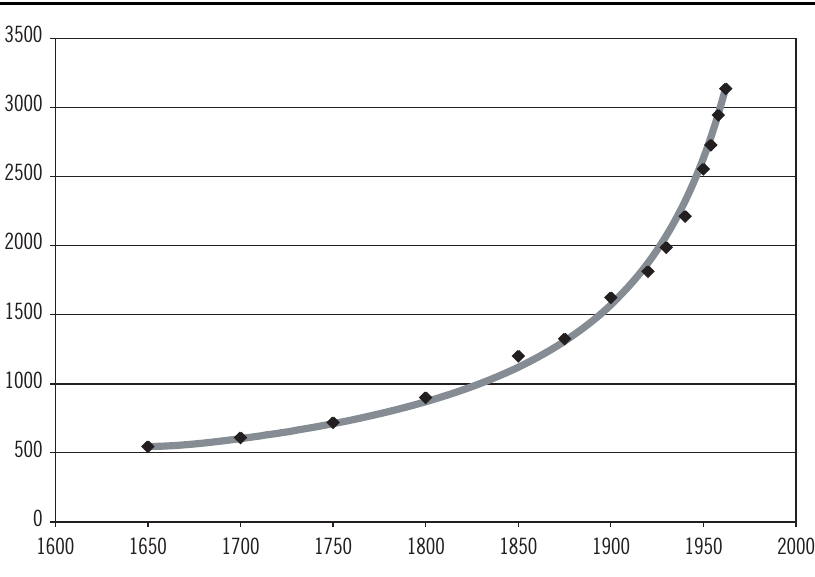
Figure 1 – Predicted and Observed Dynamics of World Population Growth, in Millions (1650–1962 ce)